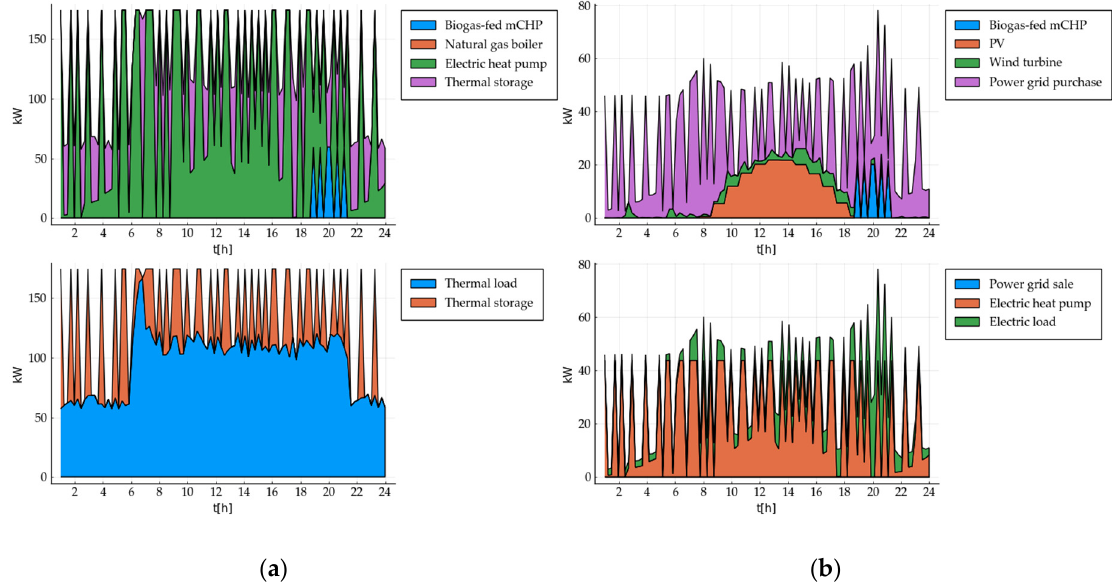
Figure 12. Daily consumption and production pattern for Case 1 (Operation Optimization) with a biogas price of 0.39 €/m 3 : thermal production ( a -up) consumption ( a -down); electricity production ( b -up) consumption ( b -down).